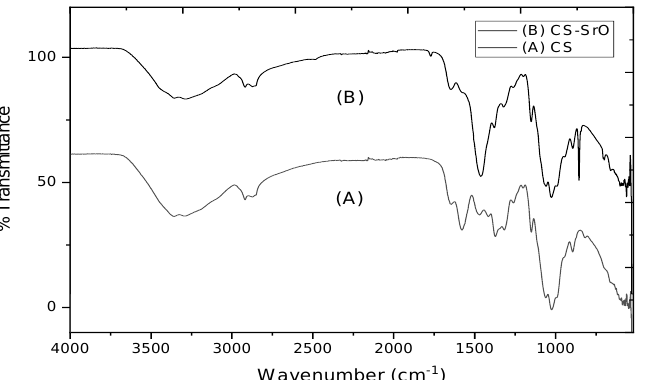
Figure 2. Comparative FTIR spectra of chitosan (A) and chitosan-strontium oxide nanocomposite (B) (10 wt.%).